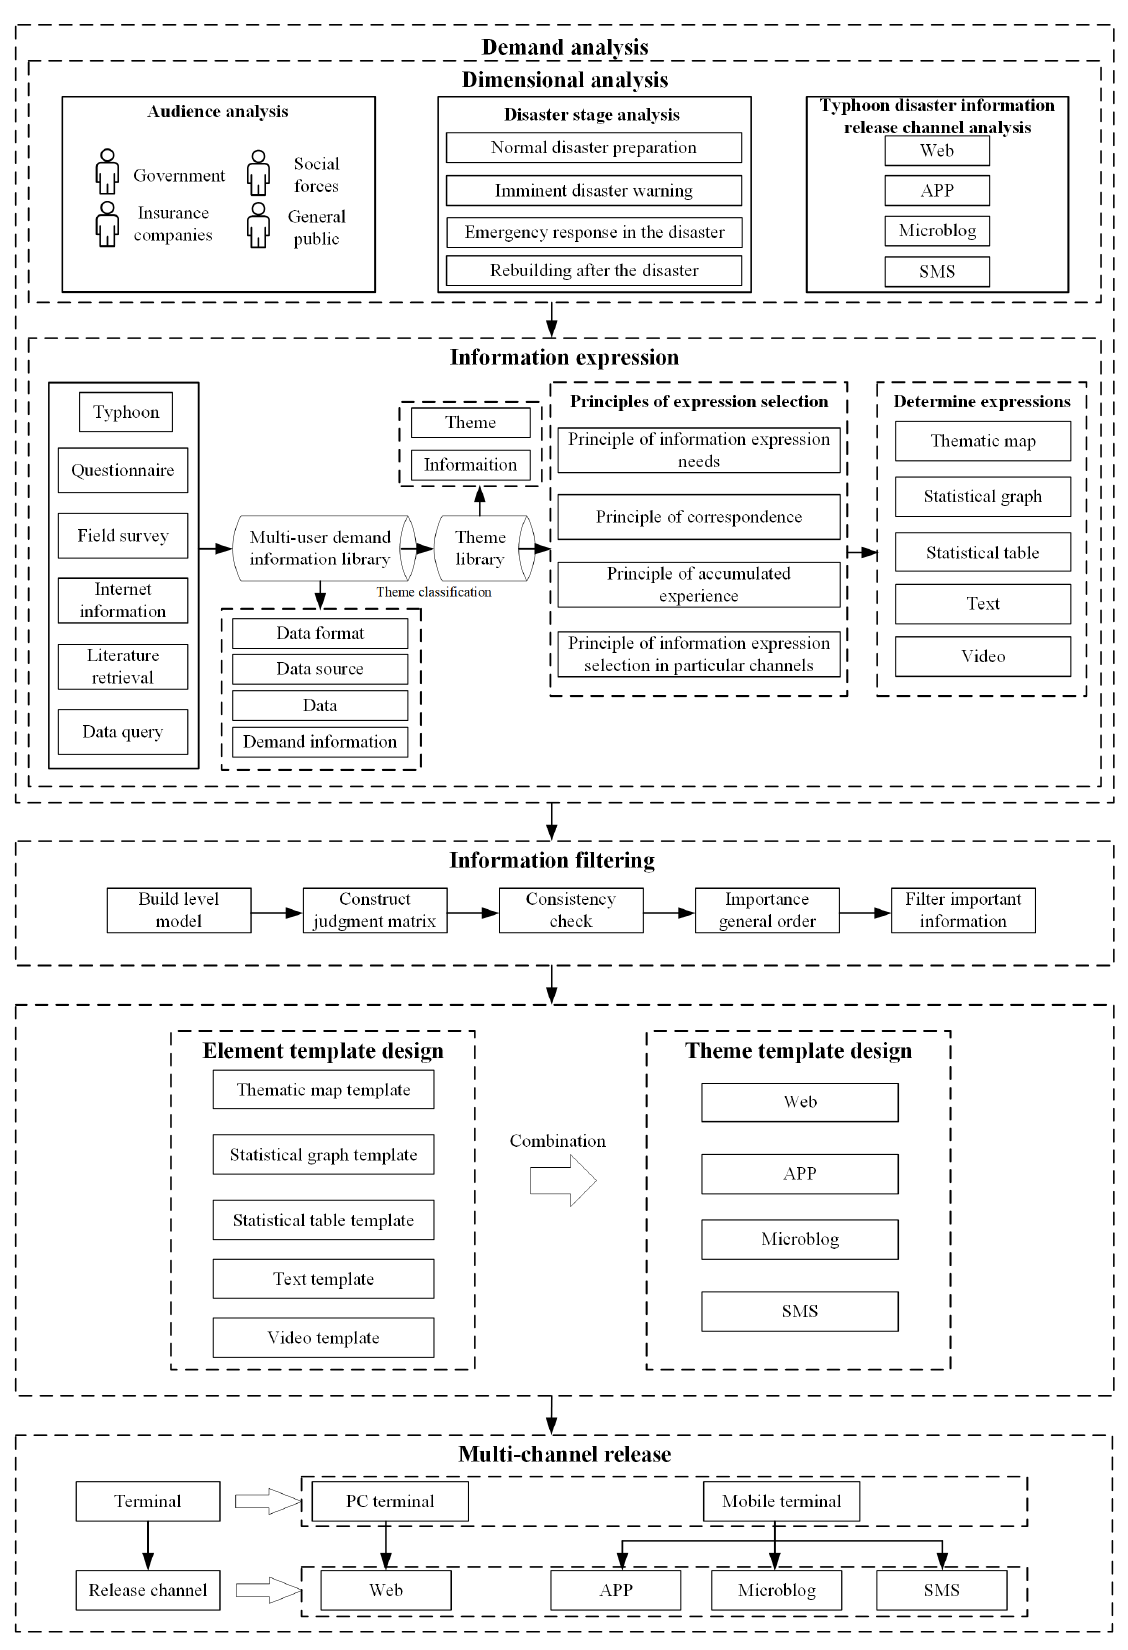
Figure 1. Overall framework for Investigation of the expression method of the theme-based typhoon disaster information.